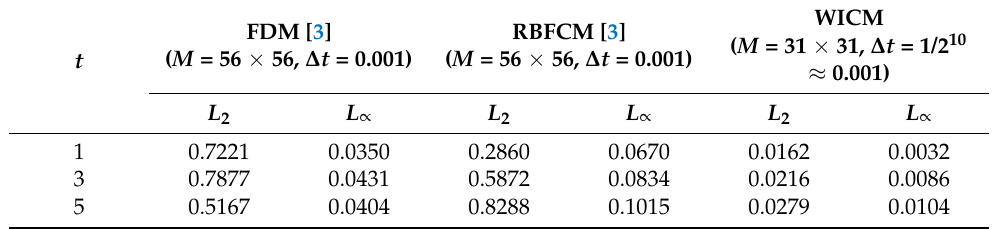
Table 5. Error norms of numerical solutions at different time t for Case I of Example 3.